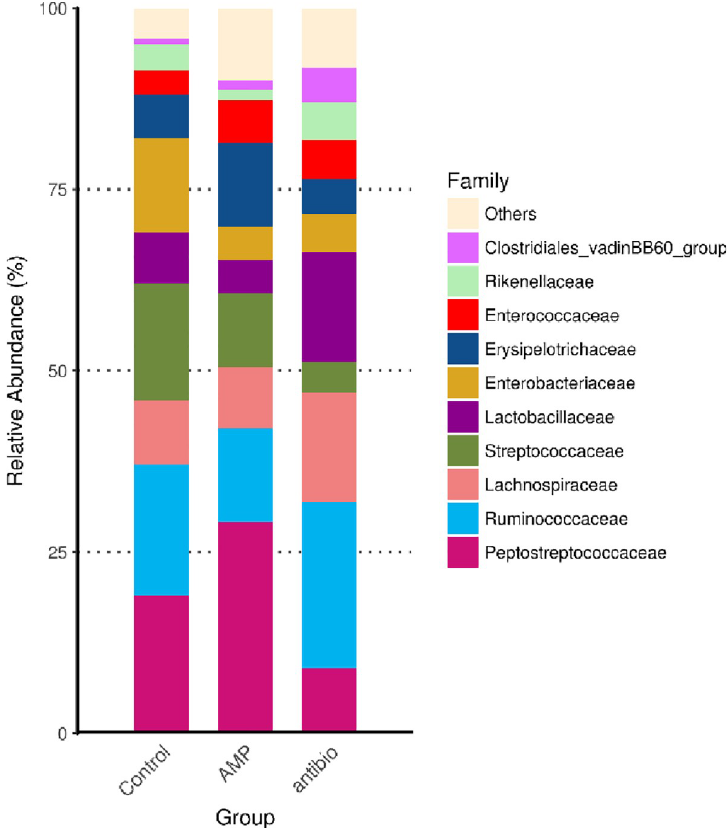
Fig 6. Effect of orally administered 3% rTP4, Spiraline-A and basal diet on the intestinal microflora in G . g . domesticus . Control: Basal diet group; AMP: 3% rTP4 group; antibio: Spiraline-A group.